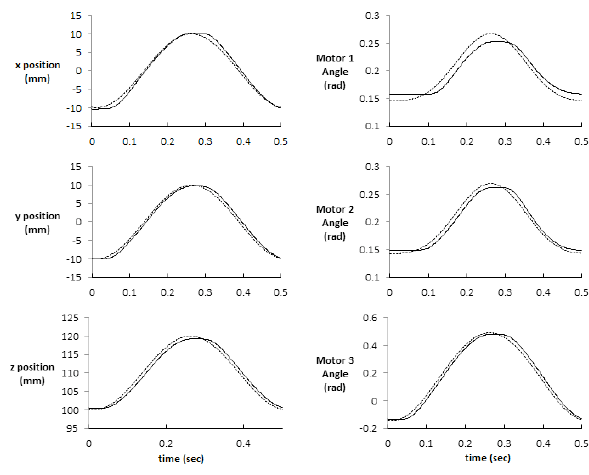
Figure 7: Trajectory response of the designed position controller Figure 10. Trajectory response of the designed position controller.